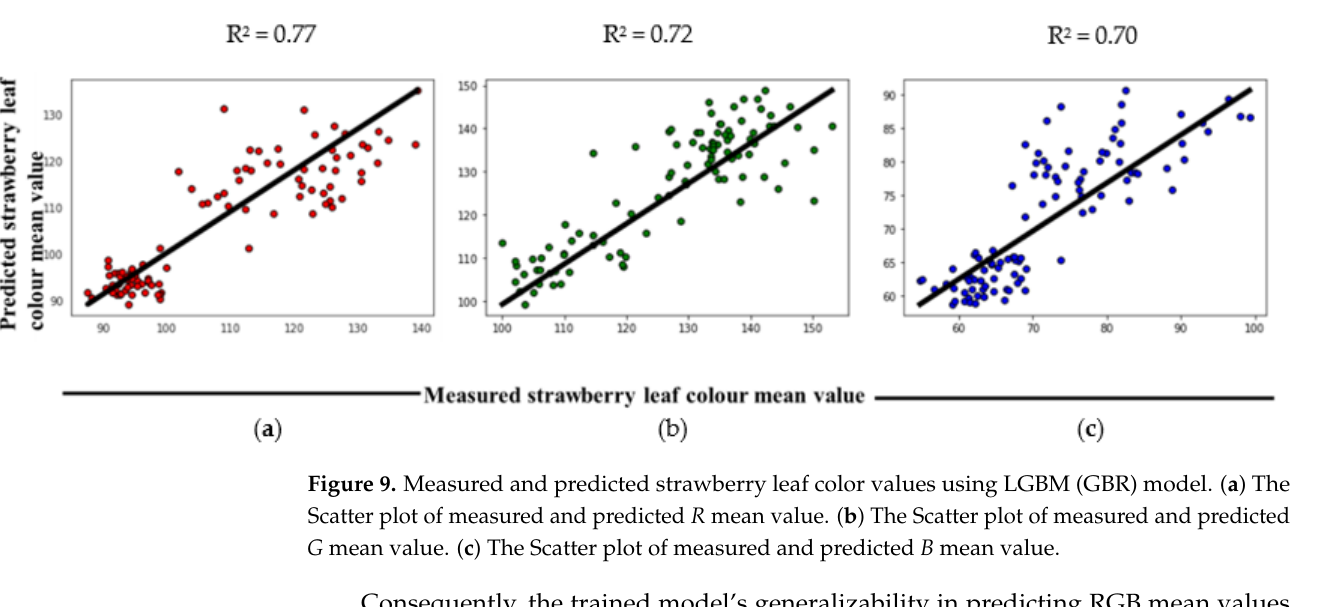
Figure 8. Measured and predicted strawberry leaf color mean values using the MLR model. ( a ) The Scatter plot of measured and predicted R mean value. ( b ) The Scatter plot of measured and predicted G mean value. ( c ) The Scatter plot of measured and predicted B mean value.